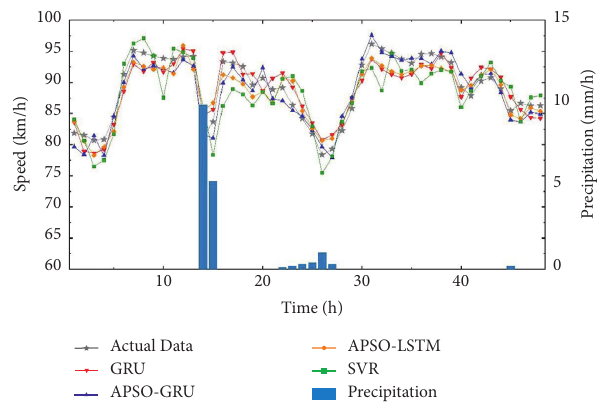
Figure 6: Prediction results of traffic flow speed during unsustained rainfall on Beijing-Harbin Highway.